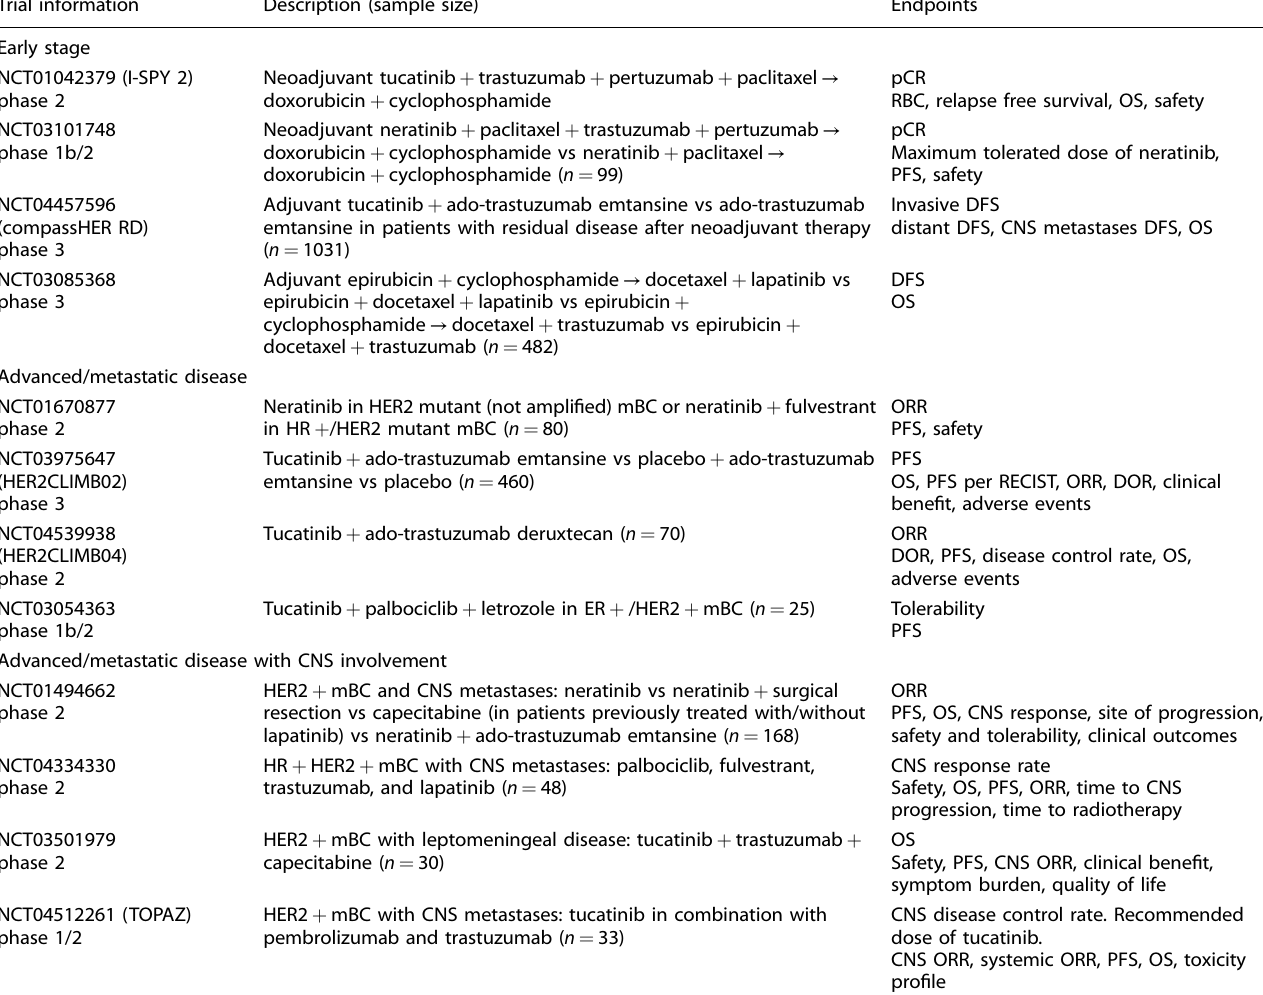
Table 3. Ongoing key phase 2 – 3 trials investigating HER-2-targeted tyrosine kinase inhibitors in breast